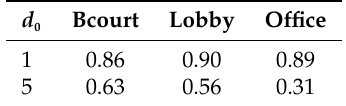
Table 2. Correlation between z